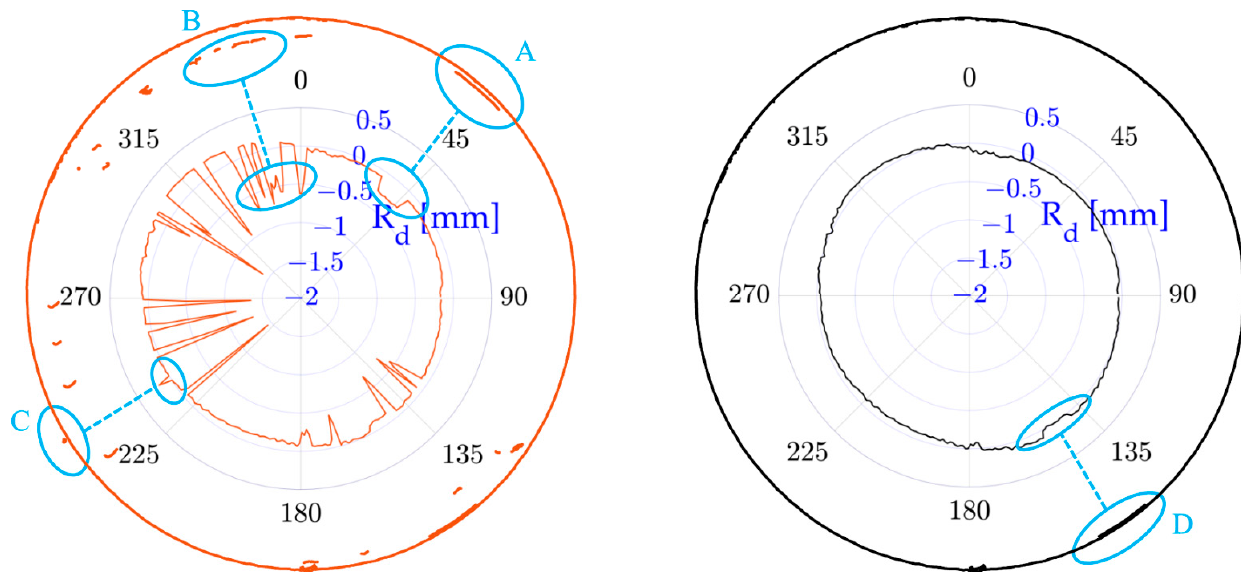
Figure 13. Polar 𝑅 (cid:3031) graphs for 𝑆02 using a T15/𝑆 (cid:3033) 15 test combination: without annular cropping (left) and with annular Figure 13. Polar R d graphs for S 02 using a T 15/ S f 15 test combination: without annular cropping ( left ) and with annular cropping (right). cropping ( right ).